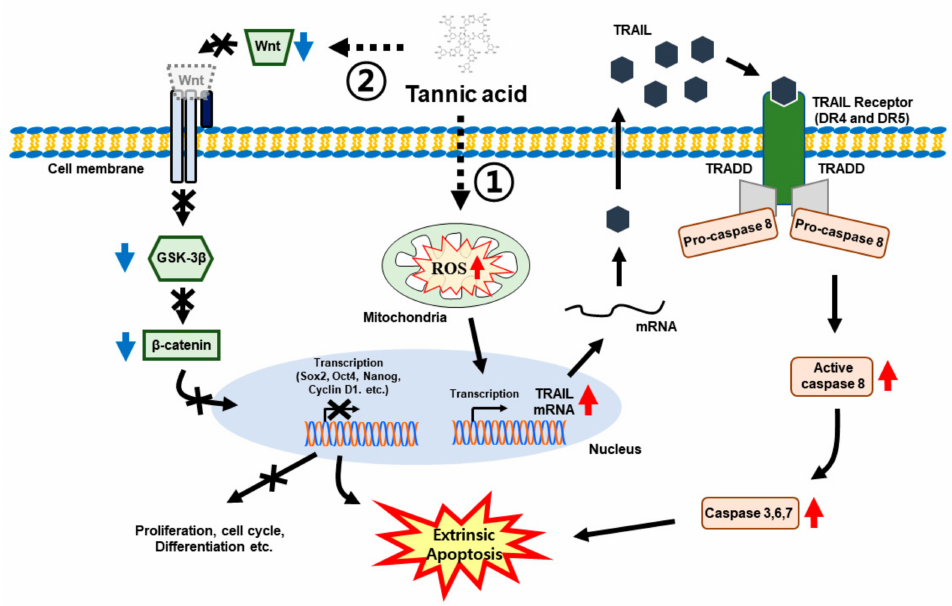
Figure 8. Molecular regulatory mechanism of Wnt / β -catenin signaling, induction of extrinsic apoptosis pathway by natural bioactive TA in NCCIT cells, and role of mROS in TRAIL-mediated extrinsic apoptosis induction with TA